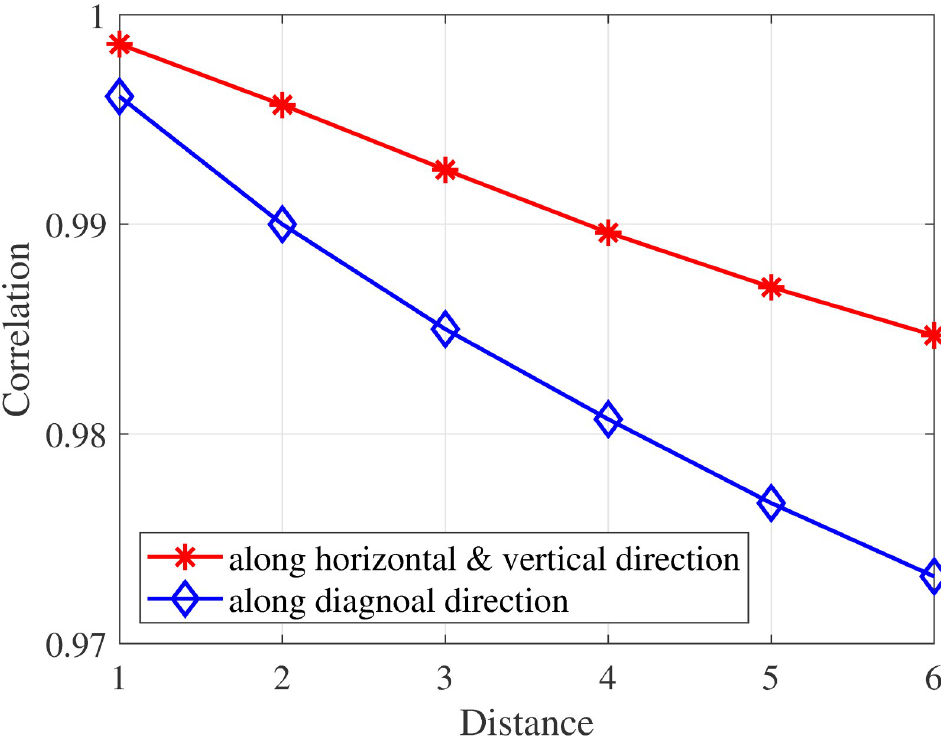
Fig 3. Correlation between adjacent pixels with pixel distance in panoramic image. The red line represents the adjacent pixels along horizontal and vertical directions, and the blue line represents the adjacent pixels along diagonal direction.